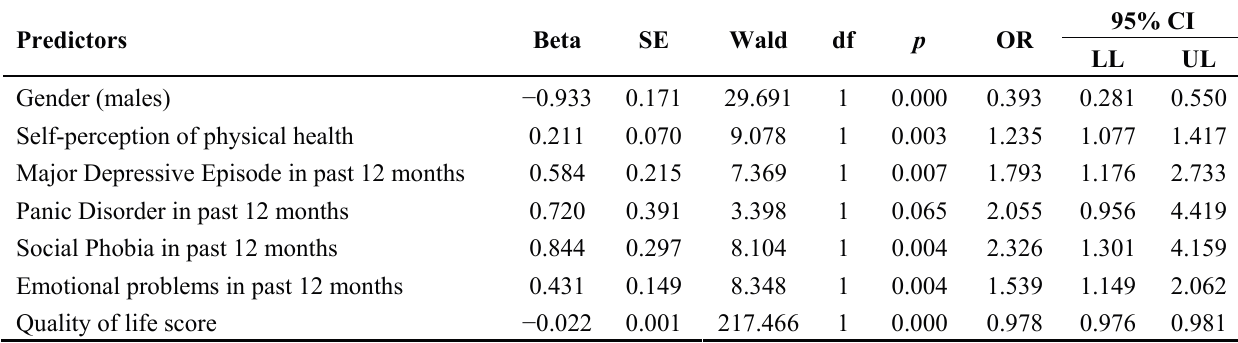
Table 4. Predictors of healthcare service utilization in the general population: multiple logistic regression (n =